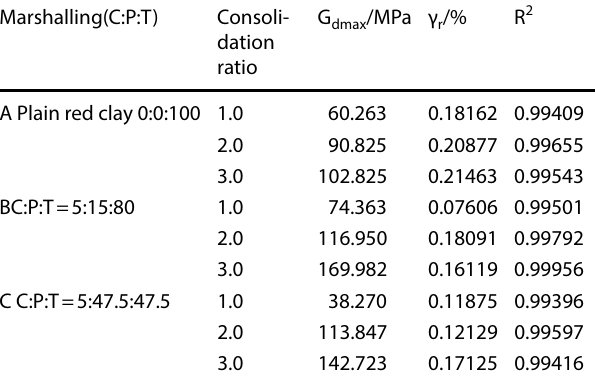
Table 8 Fitting parameters and correlation coefficients of dynamic shear modulus under different consolidation